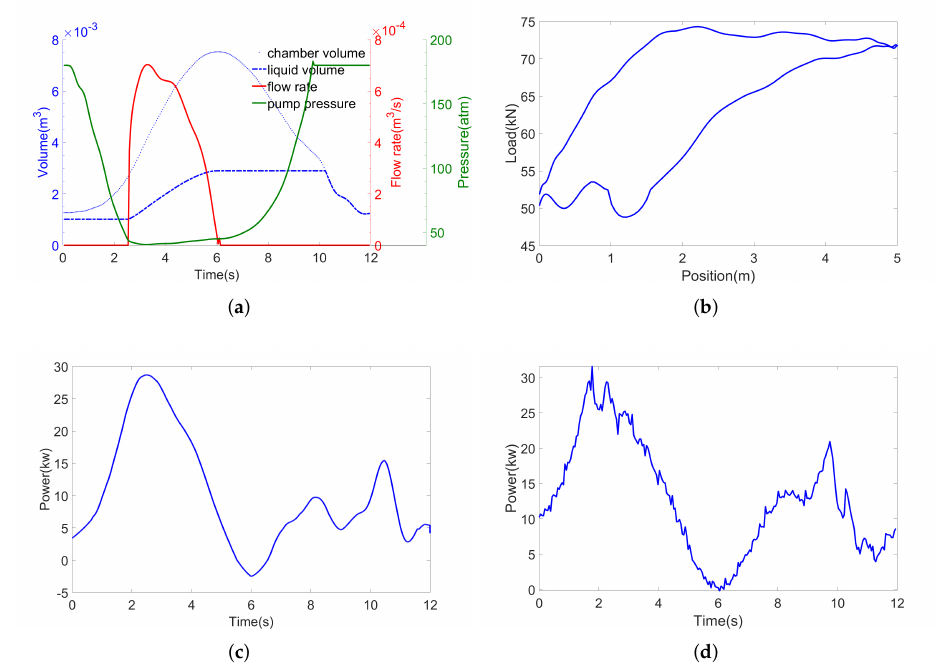
Figure 8. Insufficient liquid supply working state. ( a ) Pump simulation. ( b ) Generated DC. ( c ) Gener- ated MPC. ( d ) Actual